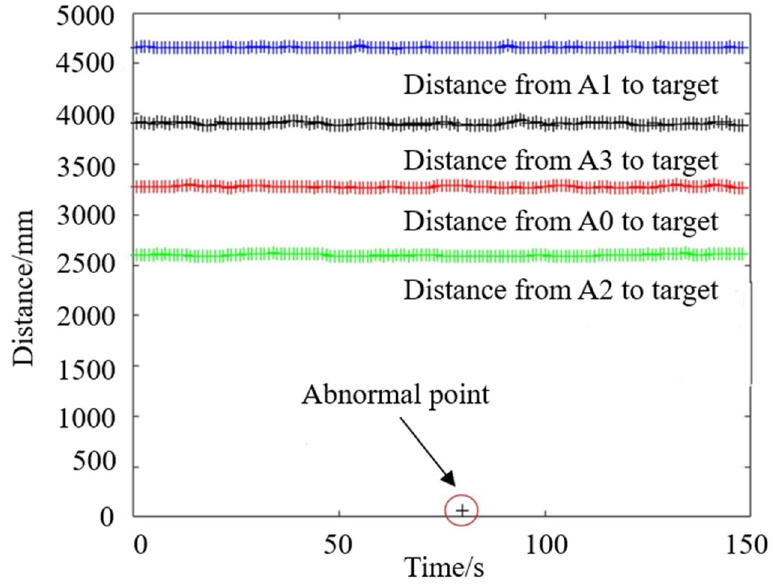
Figure 1. Data in the initial state.